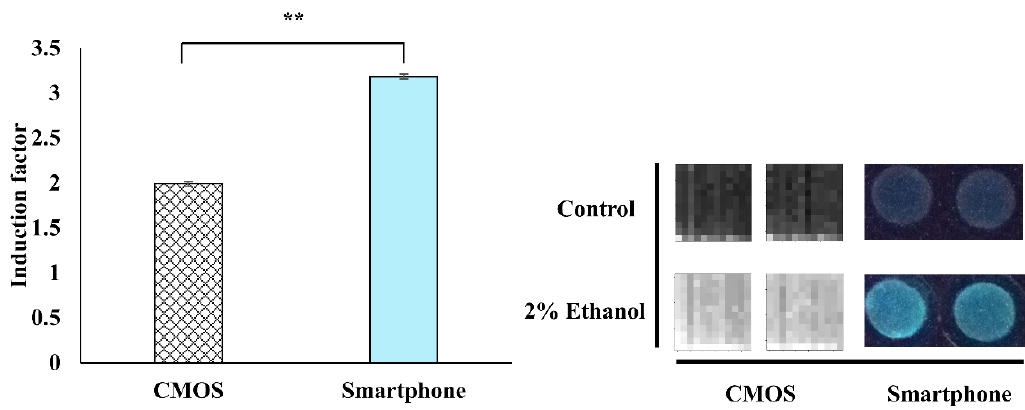
Figure 8. Comparison between CMOS-based and smartphone-based luminescent light signal detection. The response of the bioreporter bacterial strain TV1061 was examined in exposure to 2% ( v / v ) ethanol. All the values in the graph are presented as mean ± standard error of the mean (SEM), with “**” for p < 0.01 that was tested by the student’s t -test.